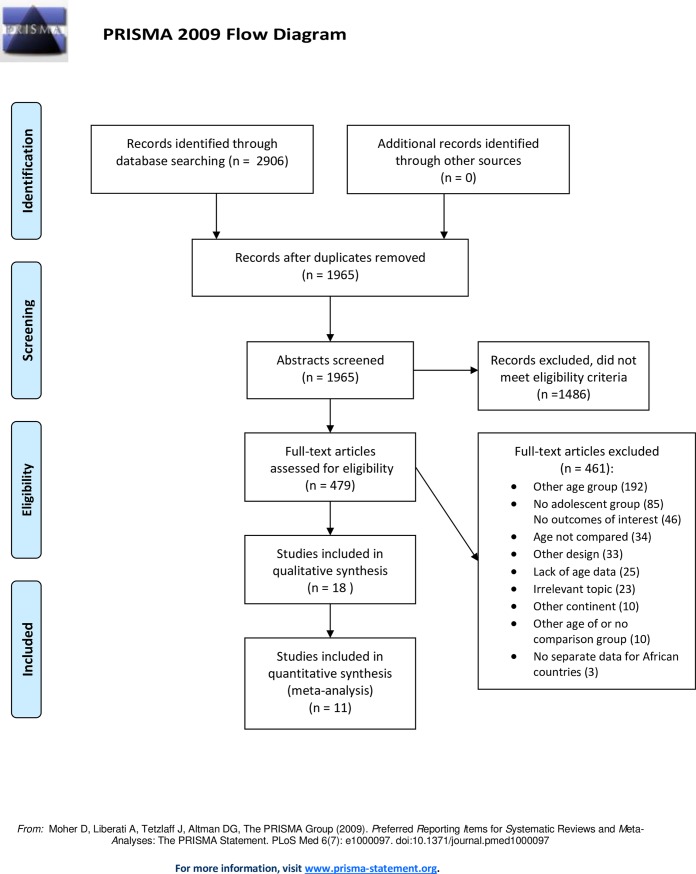
Literature review flow diagram.